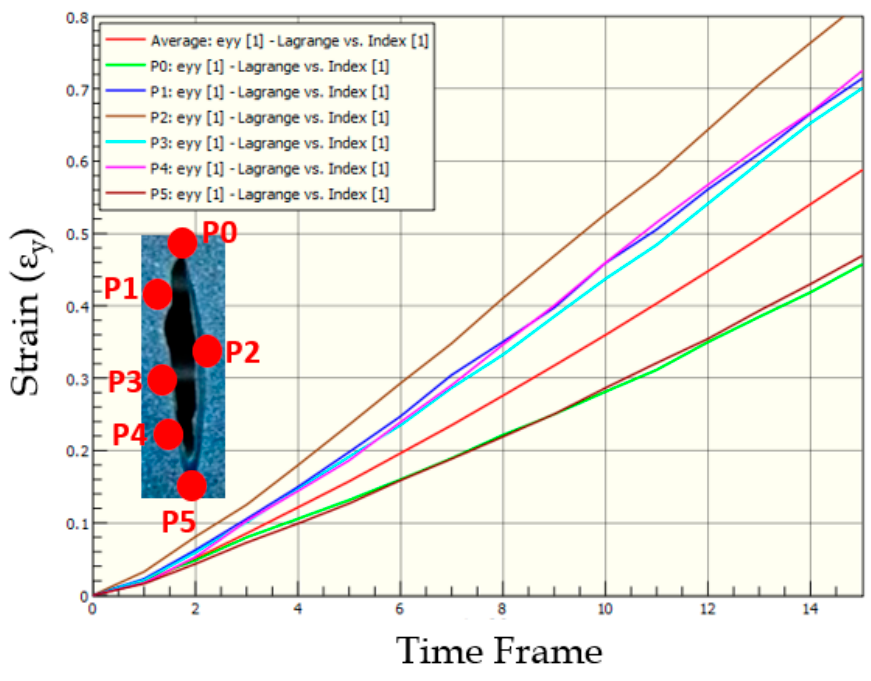
Figure 11. Average strain (y ‐ axis) versus time frame (x ‐ axis) measured using DIC from tensile test on the skin phantom specimen 2 with wound.